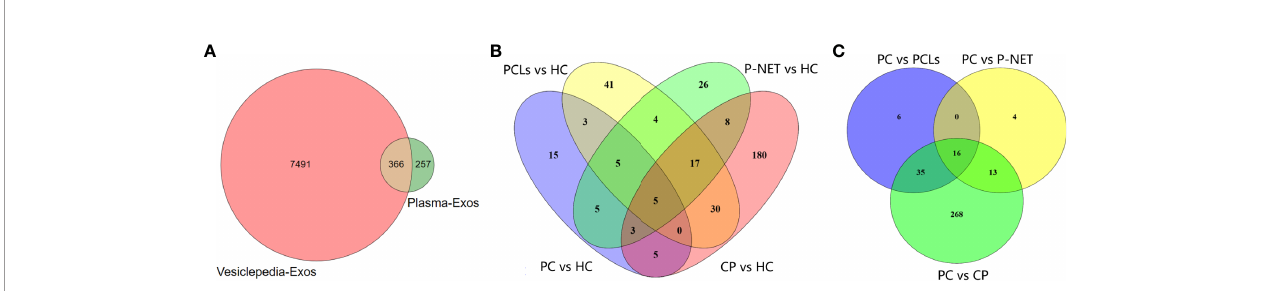
FIGURE 3 | Differential proteomic analysis of plasma-derived exosomes from patients with PC, other pancreatic diseases and healthy individuals. (A) The Venn diagram depicted the overlap of proteins identi fi ed in present study with those published in the Vesiclepedia database. (B) The overlap between differentially expressed proteins in exosomes from PC, P-NET, PCLs, and CP groups versus HC group. (C) The overlap of identi fi ed proteins differentially expressed between PC and other pancreatic